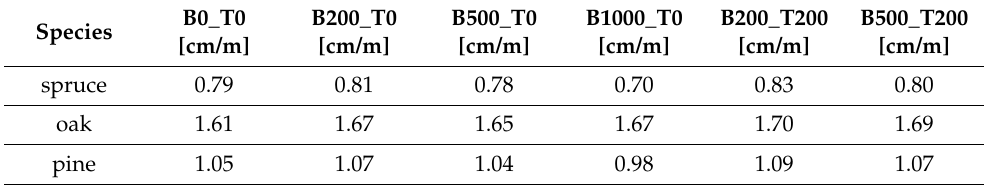
Table 2. Mean of curvature values according to the centerline method in cm/m for different combi- nations of offsets of the reference line at the butt end (B) and the top end (T) in mm for the 269 logs by species. No offset on both ends of the log (B0_T0) would result in a mean curvature of 0.79 for spruce, 1.61 for oak and 1.05 for